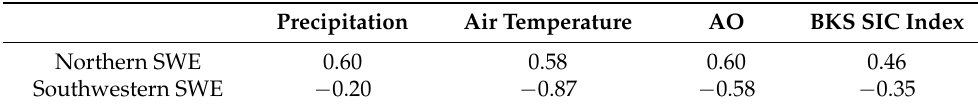
Table 2. Correlation coefficients between Eurasian snow water equivalent and precipitation, air temperature at 2 m, the Arctic Oscillation in winter and the autumn Barents–Karas sea ice concentration